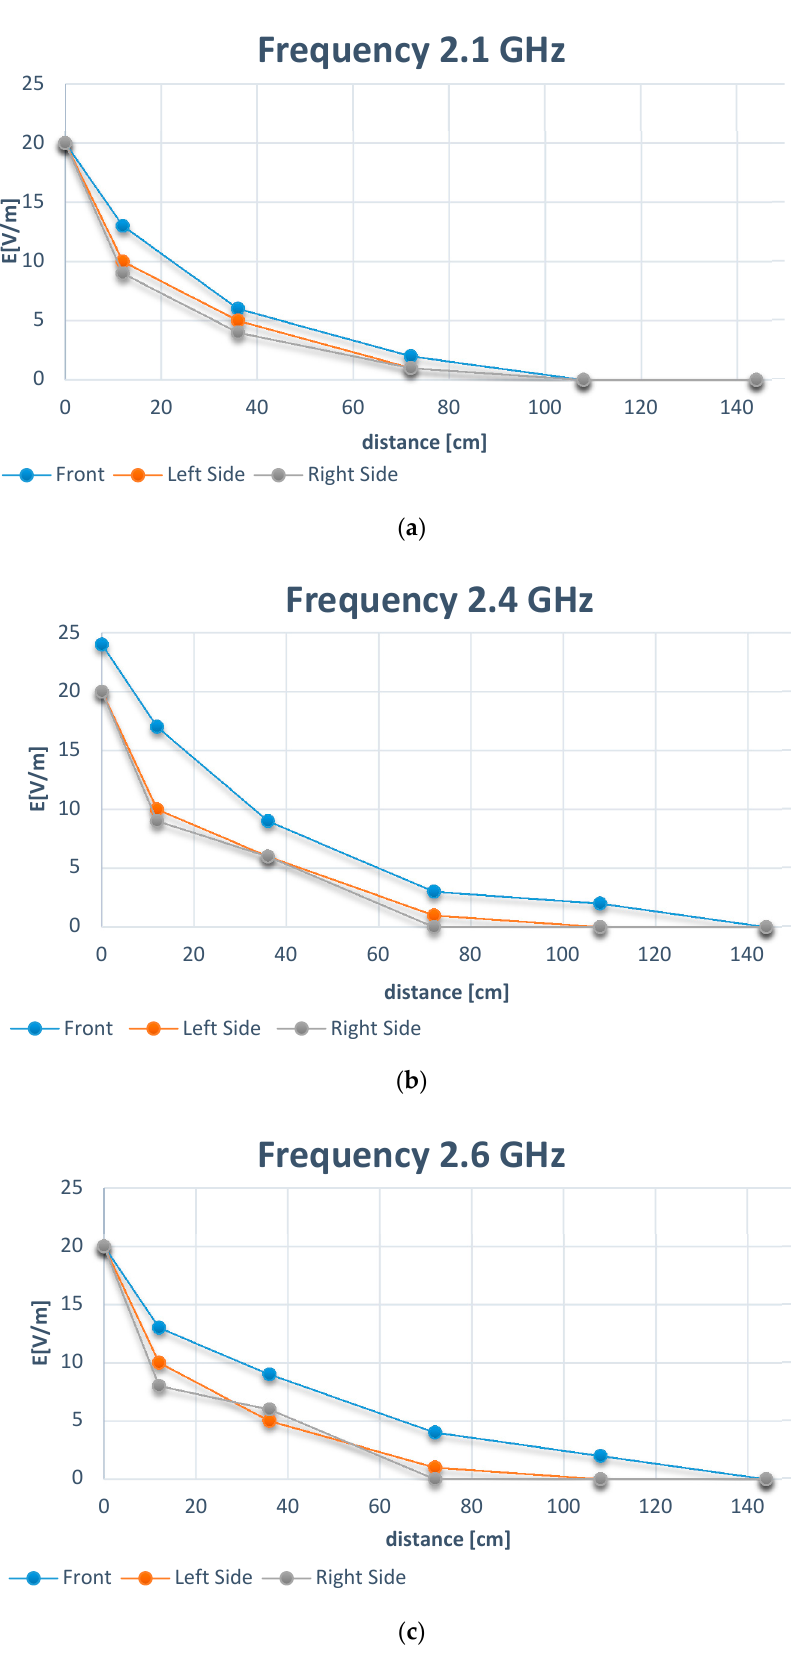
Figure 3. Electric field profile. ( a ) Frequency of 2.1 GHz; ( b ) Frequency of 2.4 GHz; ( c ) Frequency of 2.6 GHz.